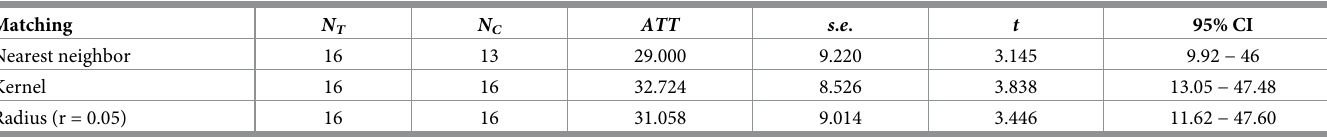
Table 2. Impact of ComFishIII on number of species caught. Matching N T N C ATT